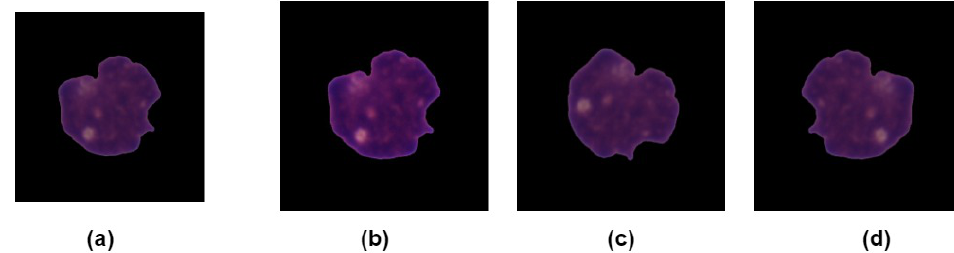
Figure 3. The result of applying data augmentation ( b – d ). ( a ) Original image ( b ) brightness correction and contrast adjustments, ( c ) rotation, and ( d ) vertical and horizontal